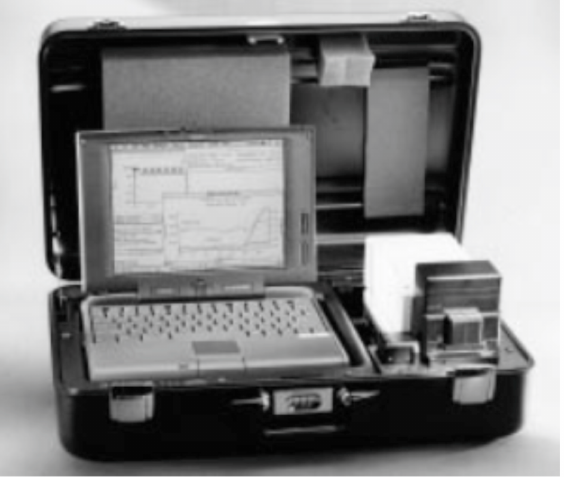
Figure 1. A photograph of the MATCI, which was the size of a briefcase and was rechargeable battery- operated. Reprinted (adapted) with permission from [13]. Copyright 1998 American Chemical